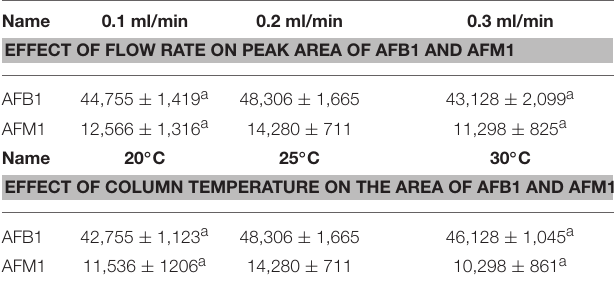
TABLE 2 | Effect of flow rate and column temperature on peak area of AFB1 and AFM1.